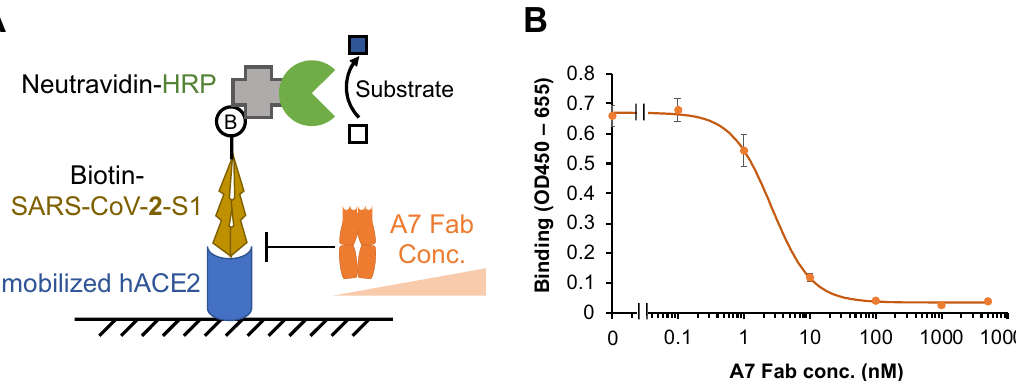
Figure 4. A7 Fab inhibits the binding of SARS-CoV-2 S1 protein to human ACE2. ( A ) The scheme for carrying out ELISA to verify the inhibition effect of A7 Fab. hACE2: recombinant human ACE2. ( B ) ELISA result showing that the binding between SARS-CoV-2 S1 and hACE2 is inhibited by A7 Fab. n = 3; Data have been expressed as mean ± standard deviation.